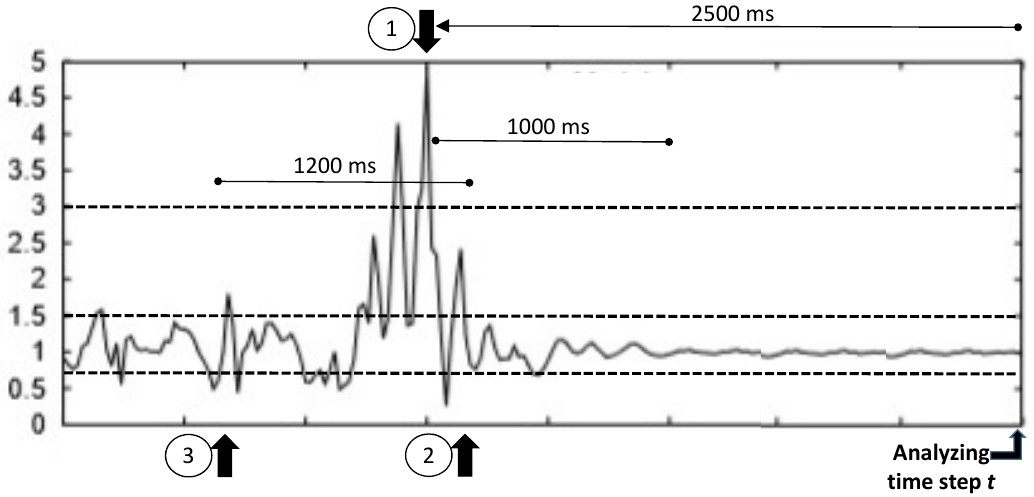
Figure 2. Graph elaborated from [33], showing the evolution of the magnitude of the acceleration in multiples of g . Analyzing the signal at time stamp t , the peak condition described in the text must be found in order to detect a fall. The X -axis represents the time, and each mark corresponds to 500